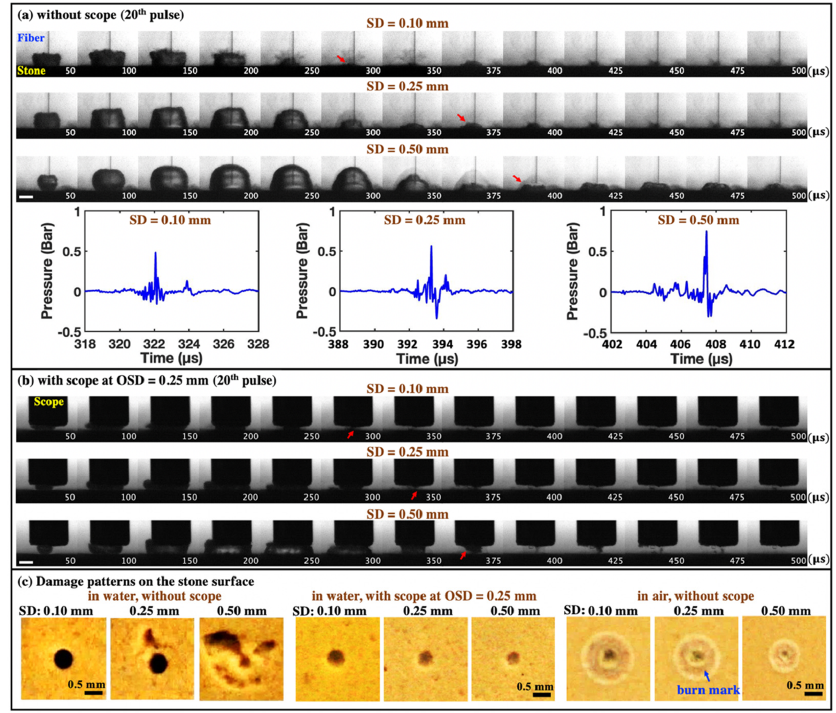
Figure 3. Representative high-speed imaging sequences of bubble dynamics produced in water near the BegoStone surfaces during dusting ( E p = 0.2 J and F = 20 Hz) using a stationary fiber. ( a ) Without the ureteroscope (or scope) at SD = 0.10 mm, 0.25 mm, and 0.50 mm and the corresponding pressure transients measured by the needle hydrophone, and ( b ) with the scope at OSD = 0.25 mm. In both ( a , b ), the red arrows indicate the direction of bubble collapse under different treatment conditions, and the scale bar = 1 mm. ( c ) Damage patterns produced on the BegoStone surfaces after 100 pulses in water without and with the scope, and in air. The blue arrow indicates the burn mark around the central